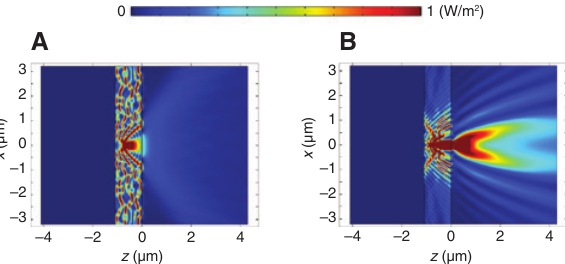
Figure 16: Full-wave (COMSOL) simulated energy flux densities for a dipole emitter embedded in a GaN slab: (A) configuration of Figure 15A and (B) configuration of Figure 15D. Original images from Ref.